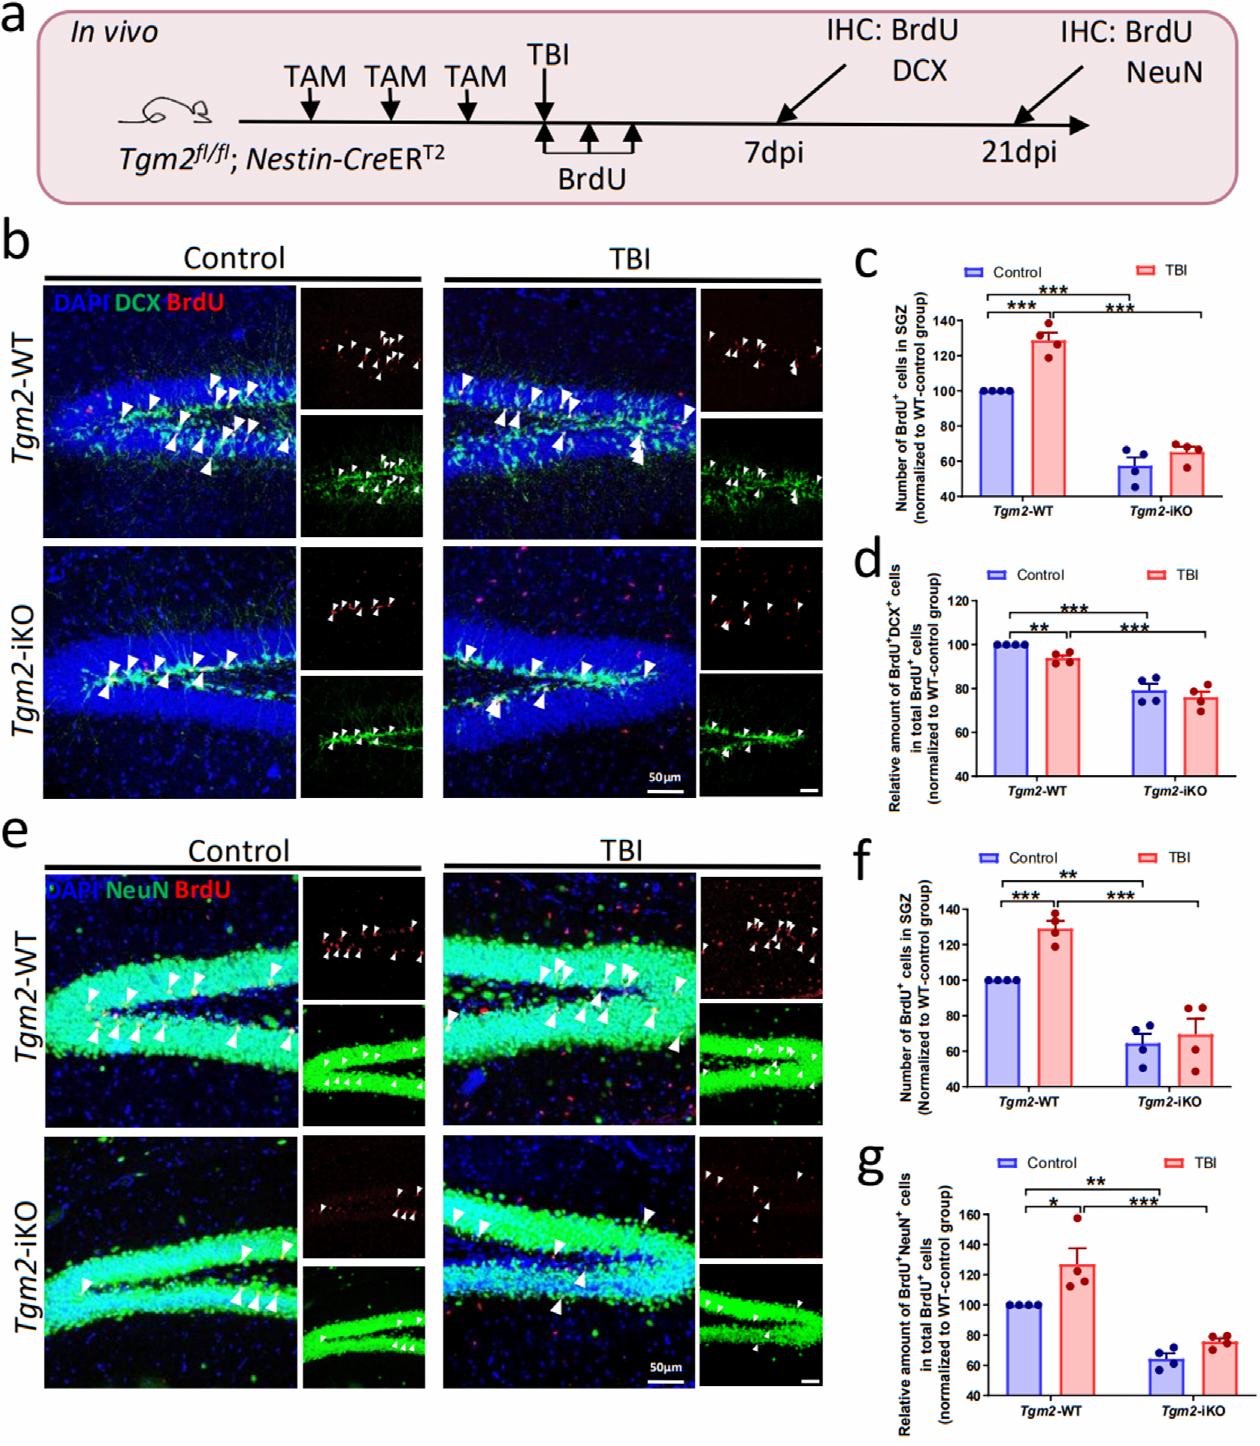
Figure 2. Deletion of TGM2 in NSPCs inhibits hippocampal neurogenesis after TBI in vivo. ( a ) Schematic illustration for analyzing neurogenesis in vivo. ( b – d ) Representative images ( b ) and quantification ( c , d ) of BrdU (red) and DCX (green) immunostainings of dentate gurus of Tgm2 iKO and WT littermates at 7 dpi. Arrowheads indicate BrdU + DCX + cells. Scale bar: 50 µ m. ( e – g ) Repre- sentative images ( e ) and quantification ( f , g ) of BrdU + cells ( f ) and BrdU + NeuN + cells ( g ) in dentate gurus of Tgm2 iKO and WT littermates at 21 dpi. n = 4 mice per group. Data are represented as means ± SEM; two-way ANOVA, * p < 0.05, ** p < 0.01, *** p <